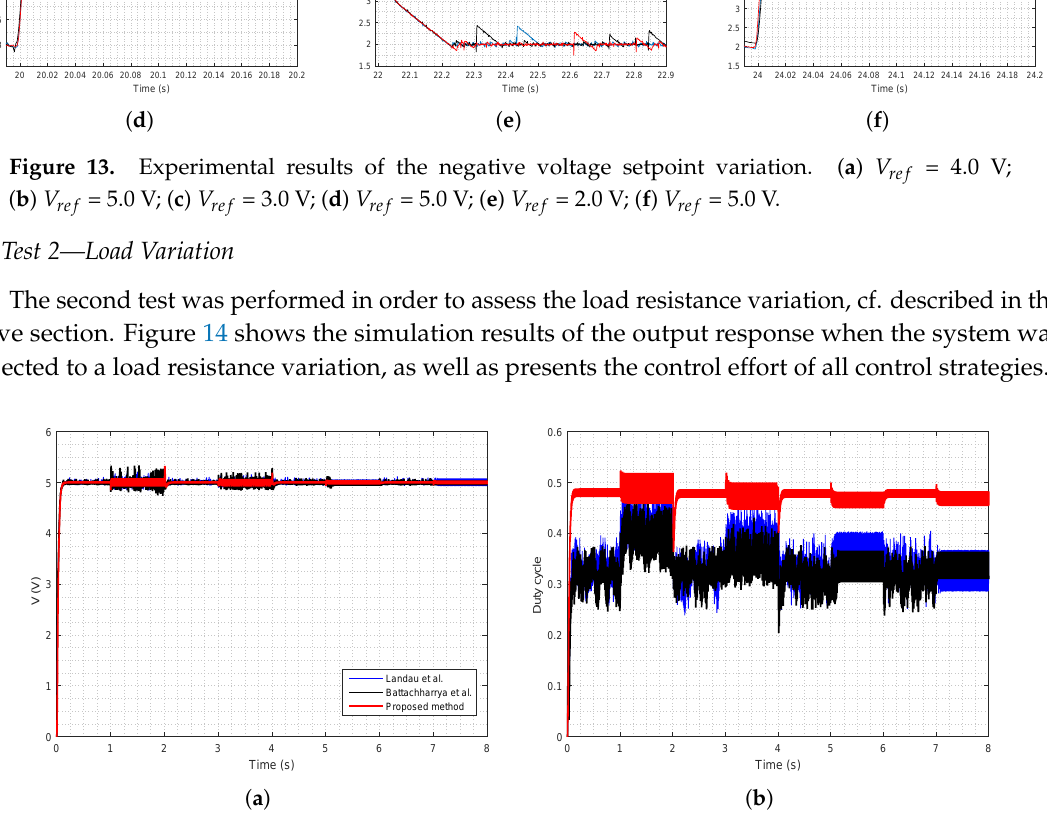
Figure 14. Simulation results of the output voltage when the system subject to a load variation. ( a ) Capacitor voltage; ( b ) Duty